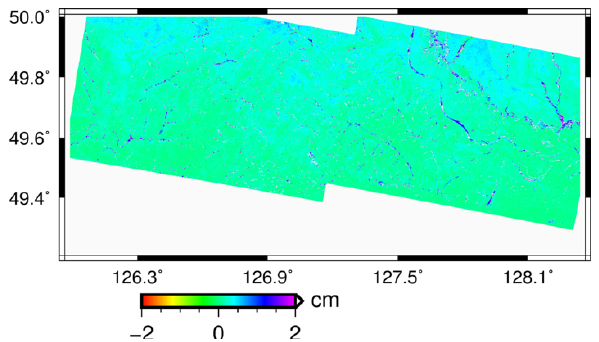
Figure 3. Short-term deformation retrieved from DInSAR processing of permafrost region from 2018/02/11 to